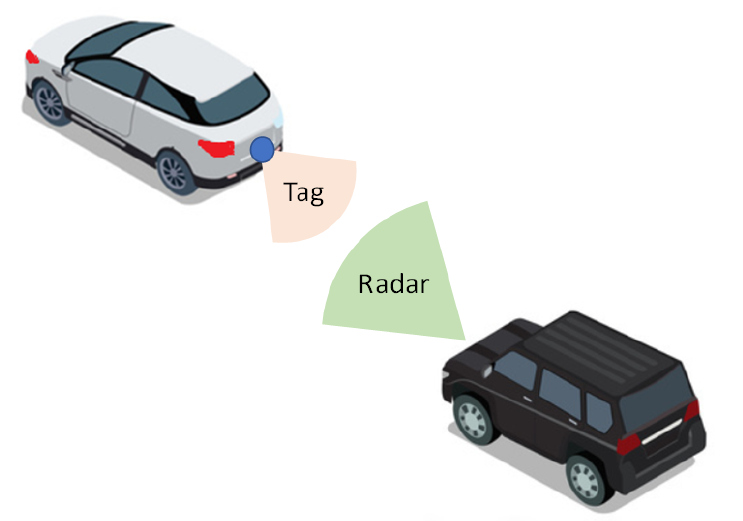
Figure 1. Schema of car2car communication based on a backscatter tag located at the rear of the vehicle and illuminated by the